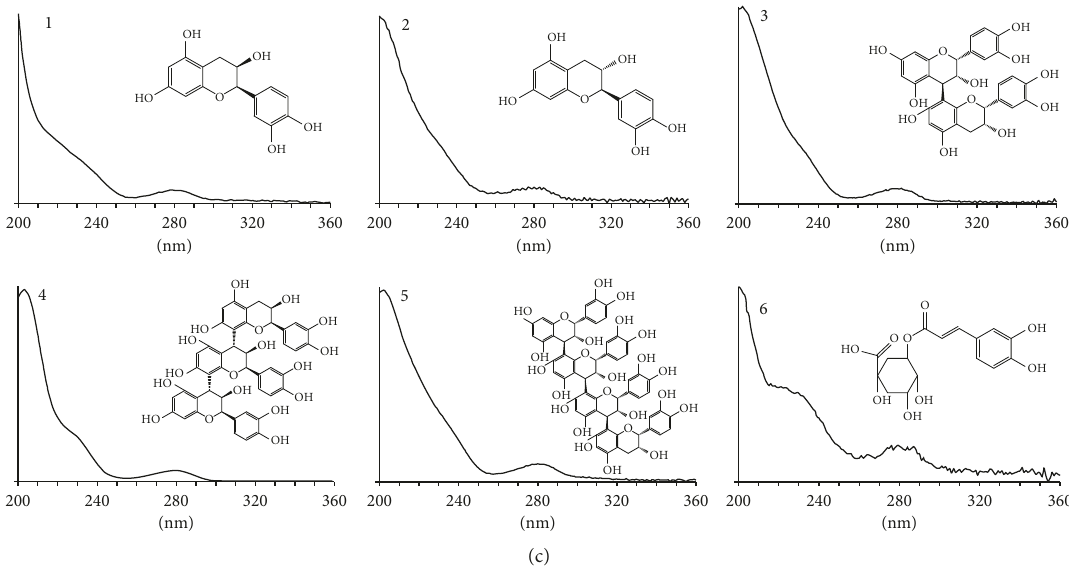
Figure 1: Electropherogram 217nm (a) and HPLC 230nm chromatogram (b) of a phenolic extract of Crataegus pubescens fruits. The spectral pattern and identity of the major compounds are shown in (c); 1. ( − )-epicatechin; 2. (+)-catechin; 3. procyanidin dimer; 4. procyanidin trimer; 5. procyanidin tetramer; 6. chlorogenic acid. Calibration curves were linear for both methods for concentration between 10 and 160 µ M for ( − )-epicatechin and (+)-catechin, with correlation coefficients of 0.9901 and 0.9959, respectively, and in a range of 10–240 µ M with a correlation coefficient of 0.9976 for chlorogenic acid. The electropherogram with the resolved standards is presented (inset) in